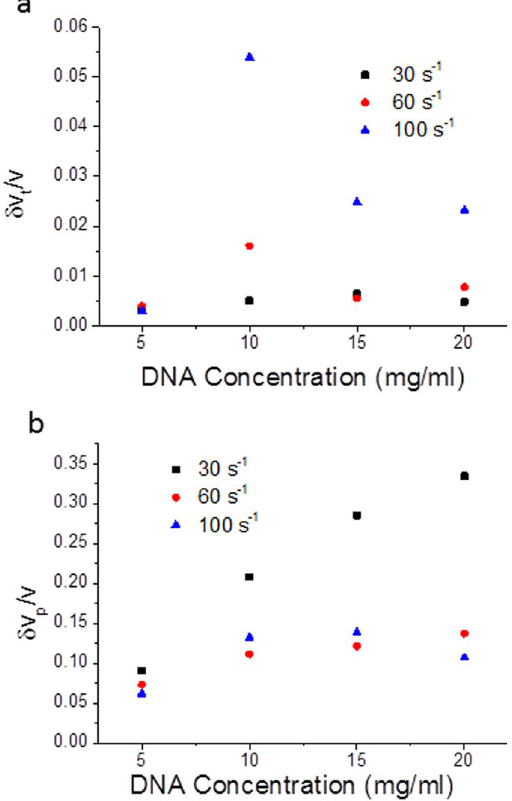
Figure 4. Reduced velocity fluctuations ( δ v/v ) averaged across the whole gap as a function of DNA concentration (high salt) for a range of applied shear rates calculated from, ( a ) the time variation of the measured velocity (long times, 1 s), and ( b ) the width of the measured Doppler signal peak (short times, 40